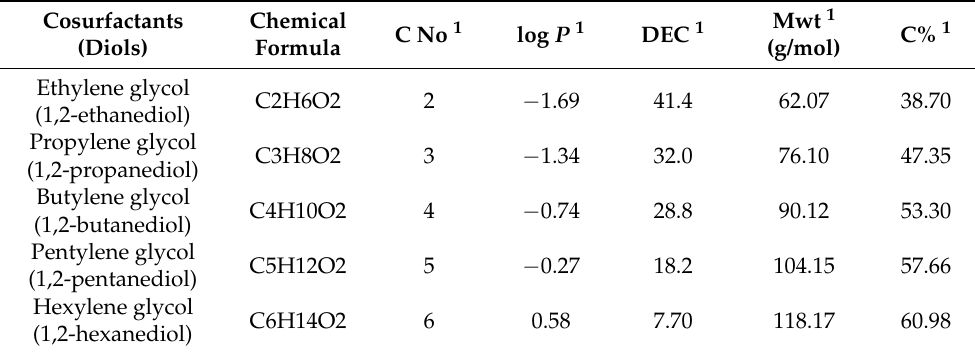
Table 4. Physicochemical properties (molecular descriptors) of selected cosurfactants (diols).